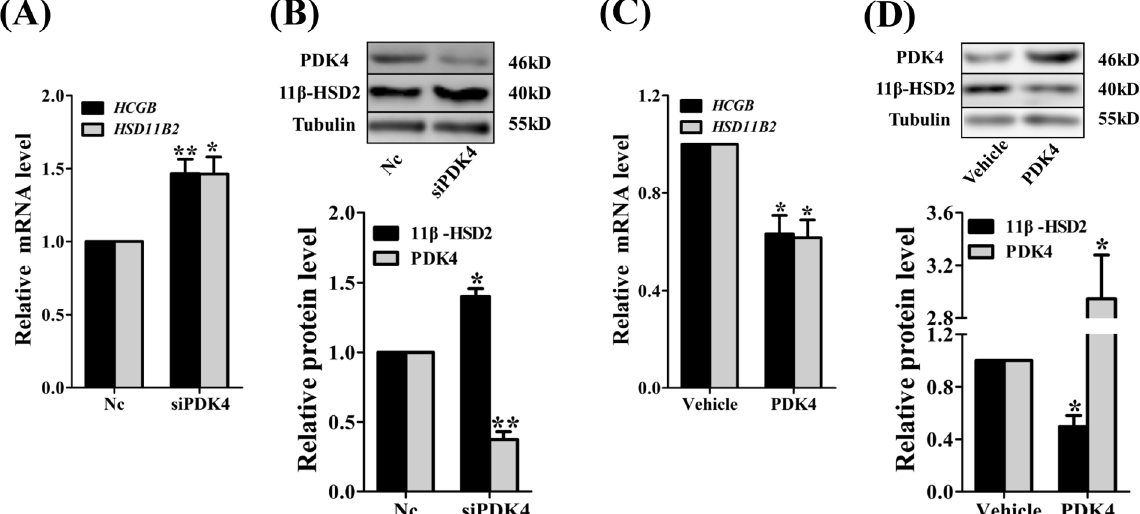
Figure 4. Role of PDK4 in syncytiotrophoblast functions. ( A ) and ( B ) The abundance of 11 β -HSD2 mRNA (n = 4, A ) and protein (n = 3, B ) and β -hCG mRNA (n = 4, A ) was significantly increased by siRNA-mediated knock-down of PDK4 expression. Randomly scrambled siRNA served as negative control (Nc). (C) and ( D ) Over-expression of PDK4 significantly decreased the abundance of 11 β -HSD2 mRNA (n = 4, C ) and protein (n = 3, D ) and β -hCG mRNA (n = 4, C ). * P < 0.05; ** P < 0.01; *** P < 0.001 against Nc ( A and B ) or Vehicle ( C and D ).